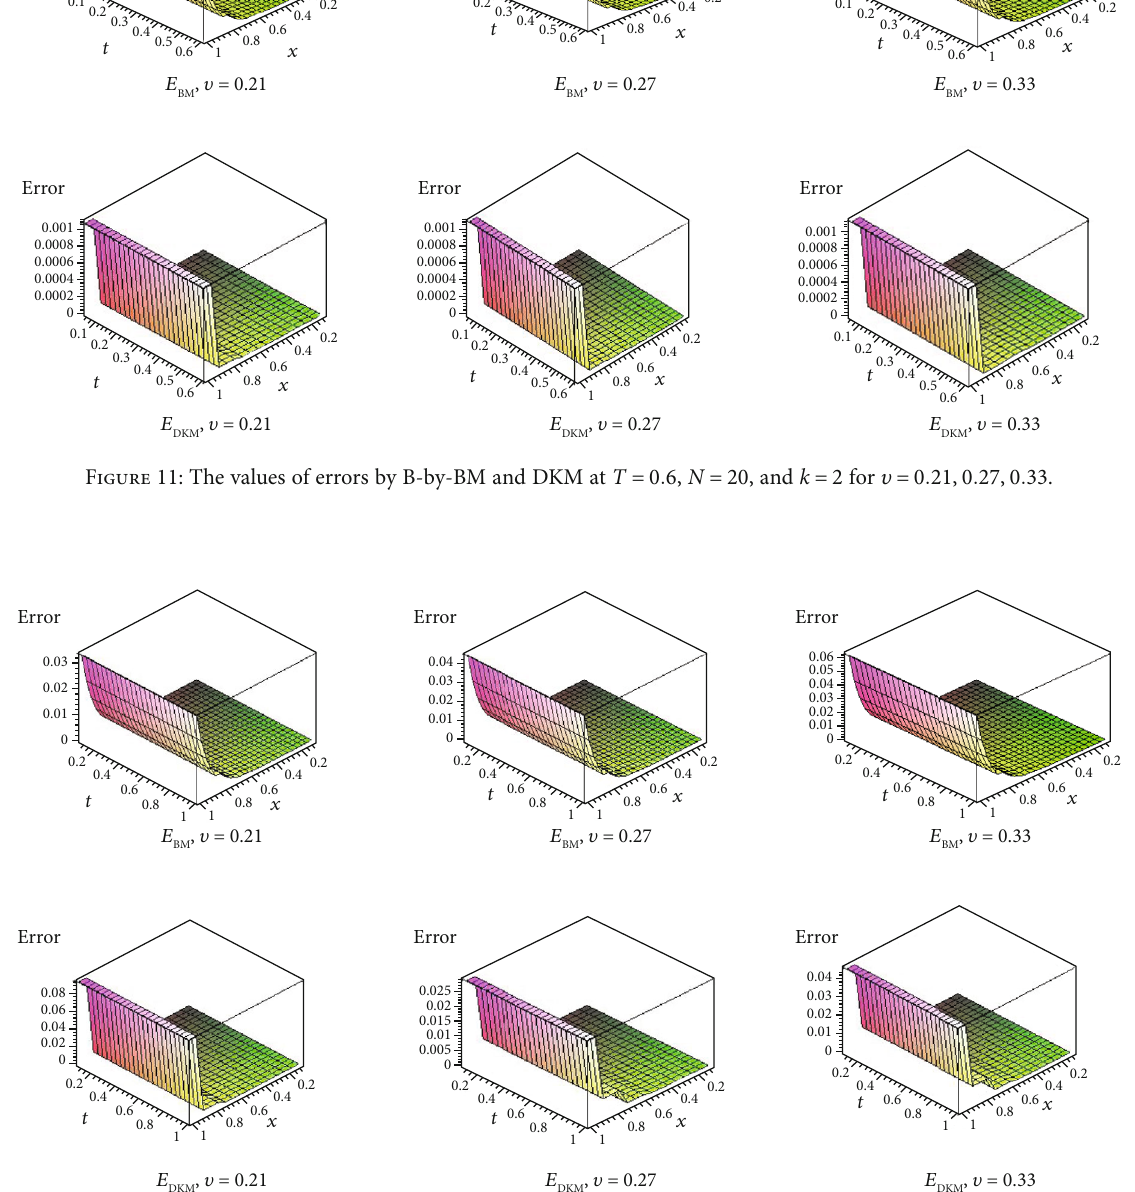
Figure 12: The values of errors by B-by-BM and DKM at T = 1 , N = 20 , and k = 2 for υ = 0 : 21, 0 : 27, 0 : 33